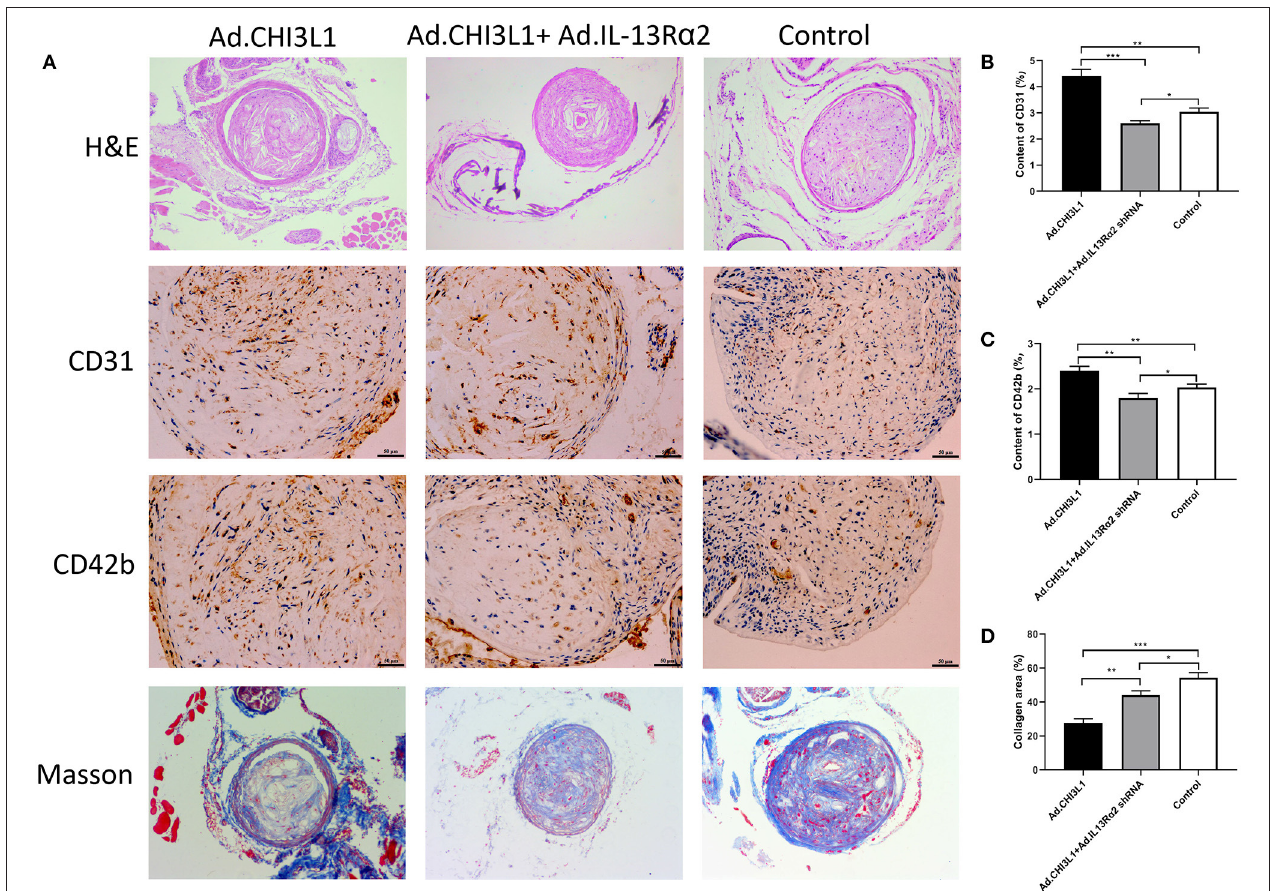
FIGURE 2 | Atherosclerotic lesion and expression of CD31, CD42b, and collagen in carotid plaques of apoE − / − mice pretreated with carotid collar placement. Representative H&E staining, immunohistochemical images of CD31 and CD42b, and Masson trichrome staining in carotid plaques (A) . Quantification of CD31, CD42b, and collagen in atherosclerotic lesions (B–D) . Data were presented as mean ± SD ( n = 3 per group). * p < 0.05, ** p < 0.01, and *** p <